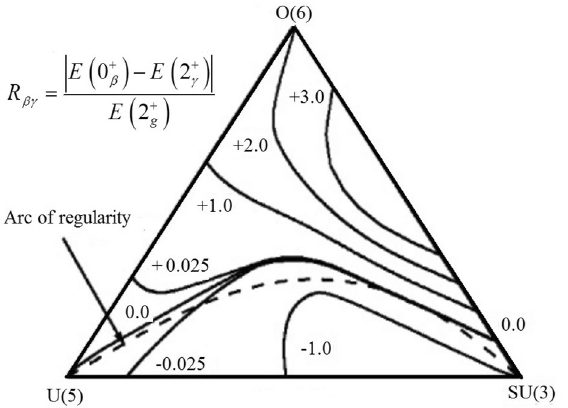
Figure 1. Standard symmetry triangle which is similar with the predictions of Ref. 17 . Different values of R βγ and also the location of regular nuclei are identified